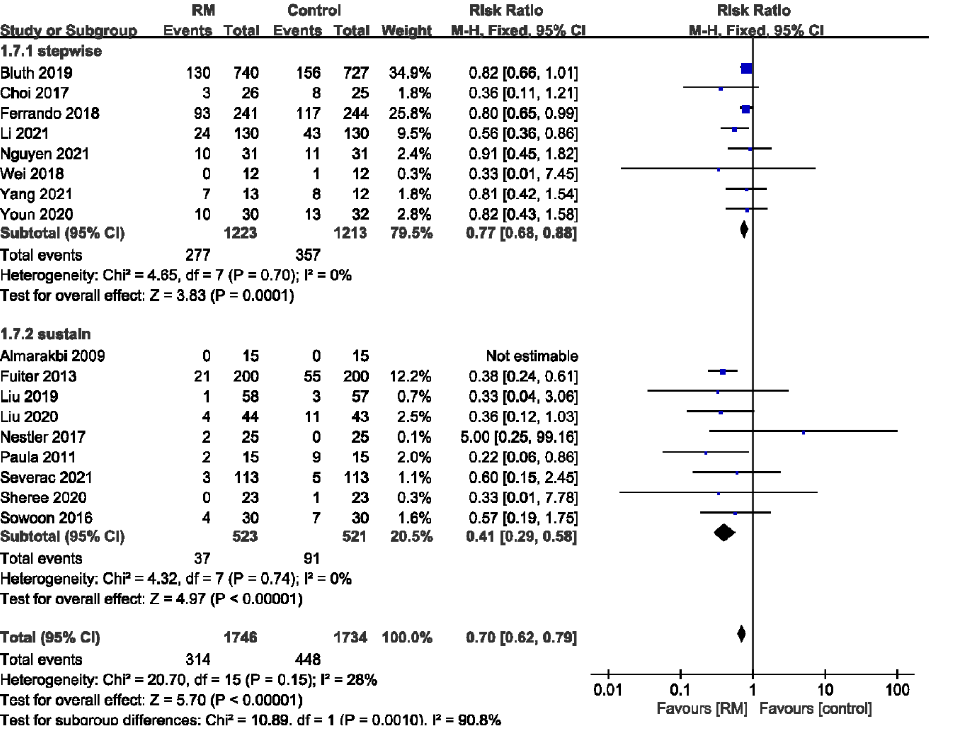
Figure 7. Forest plot for subgroup analysis of the incidence of PPCs between RM and control groups. Grouped by the type of RM: stepwise RM, sustained RM [16 – 32].